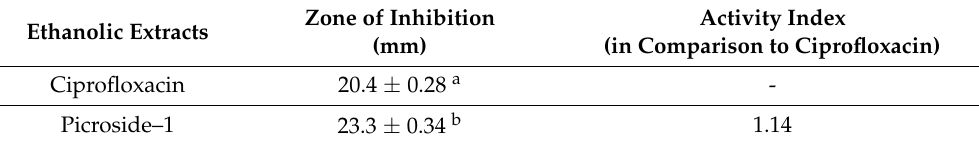
Table 3. Antimicrobial potential of picroside – 1 compounds against Yersinia enterocolitica.